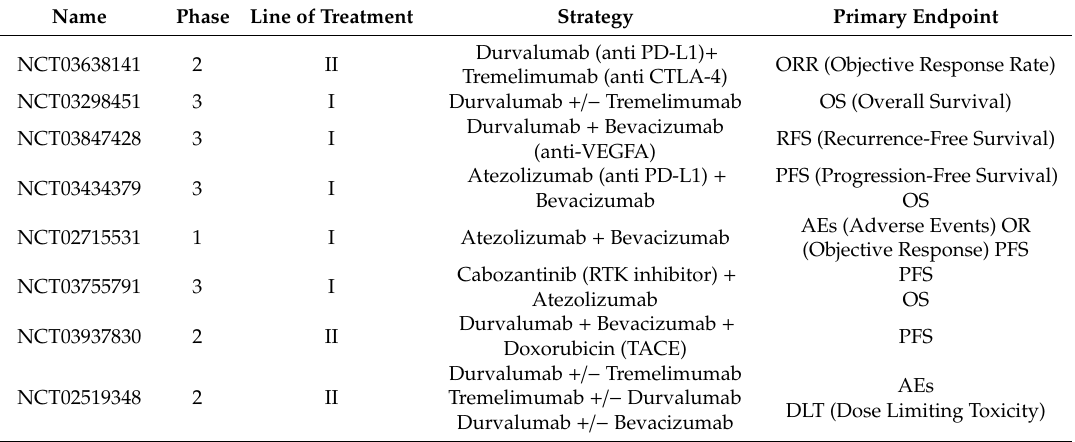
Table 3. Major trials in HCC involving anti-PD-L1 agents-based immunotherapies.